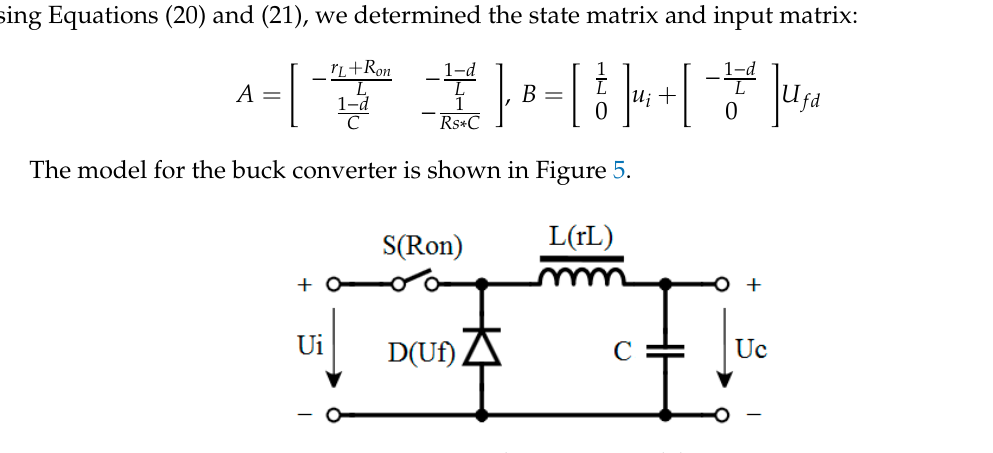
Figure 5. Buck converter